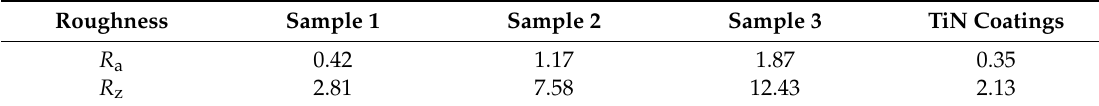
Figure 8. Surface profile of the specimen ( a – c represent samples 1, 2, and 3 respectively). Table 7. Surface roughnessof each sample and TiN coatings and Ti6Al4V.